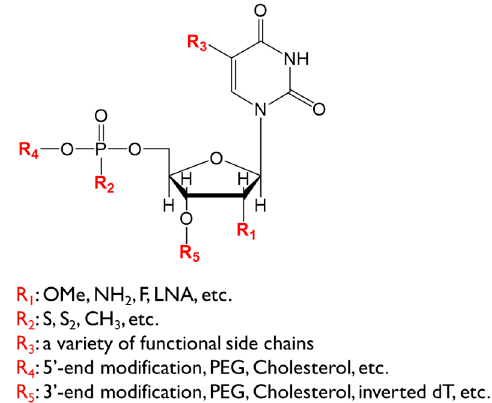
Figure 2. Chemical structure of a polynucleotide element. Modifications at the indicated positions are shown. OMe: O-methylation, LNA: locked nucleic acid, PEG: polyethylene glycol.